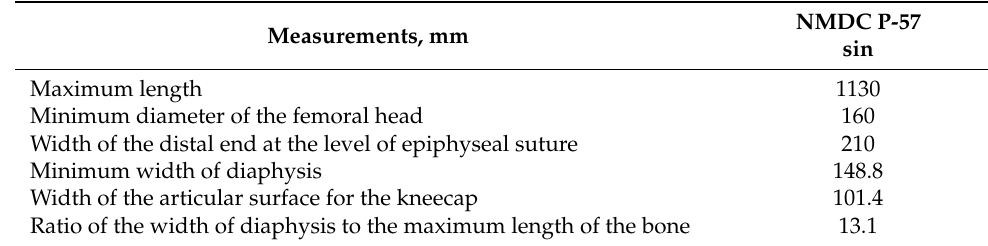
Table 4. Measurements of the femur of Mammuthus intermedius from Kamensk-Shakhtinskiy (the early Late Pleistocene; Rostov Region, Russia).